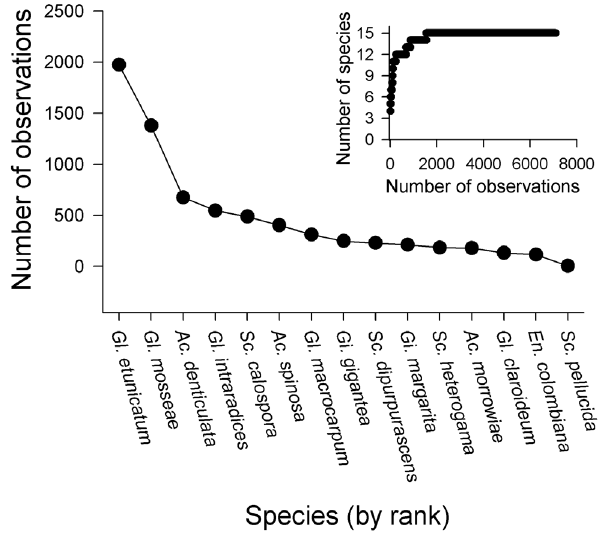
Figure 1. The frequency of AM fungal species across the 50 m 6 50 m sampled grid and a species rarefaction curve (inset).